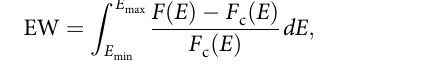
Supplementary Fig. 6 plots the time evolution of the